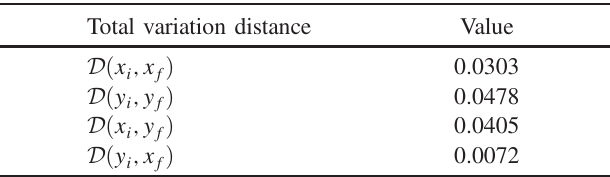
TABLE II. Total variation distances between 2D laser wire scan results and 2D projections of the four-scan 4D reconstructed transverse phase space distribution.